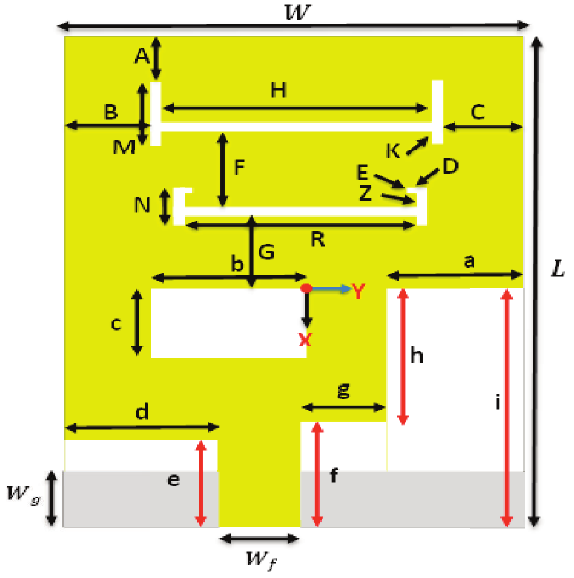
Fig. 1. Dimensions of the monopole antenna (in